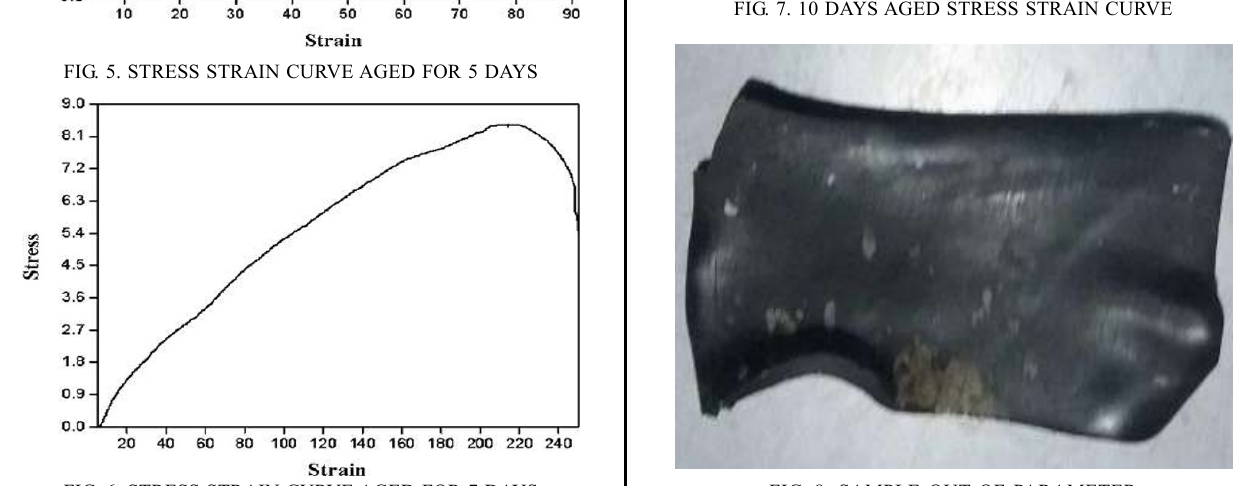
FIG. 7. 10 DAYS AGED STRESS STRAIN CURVE